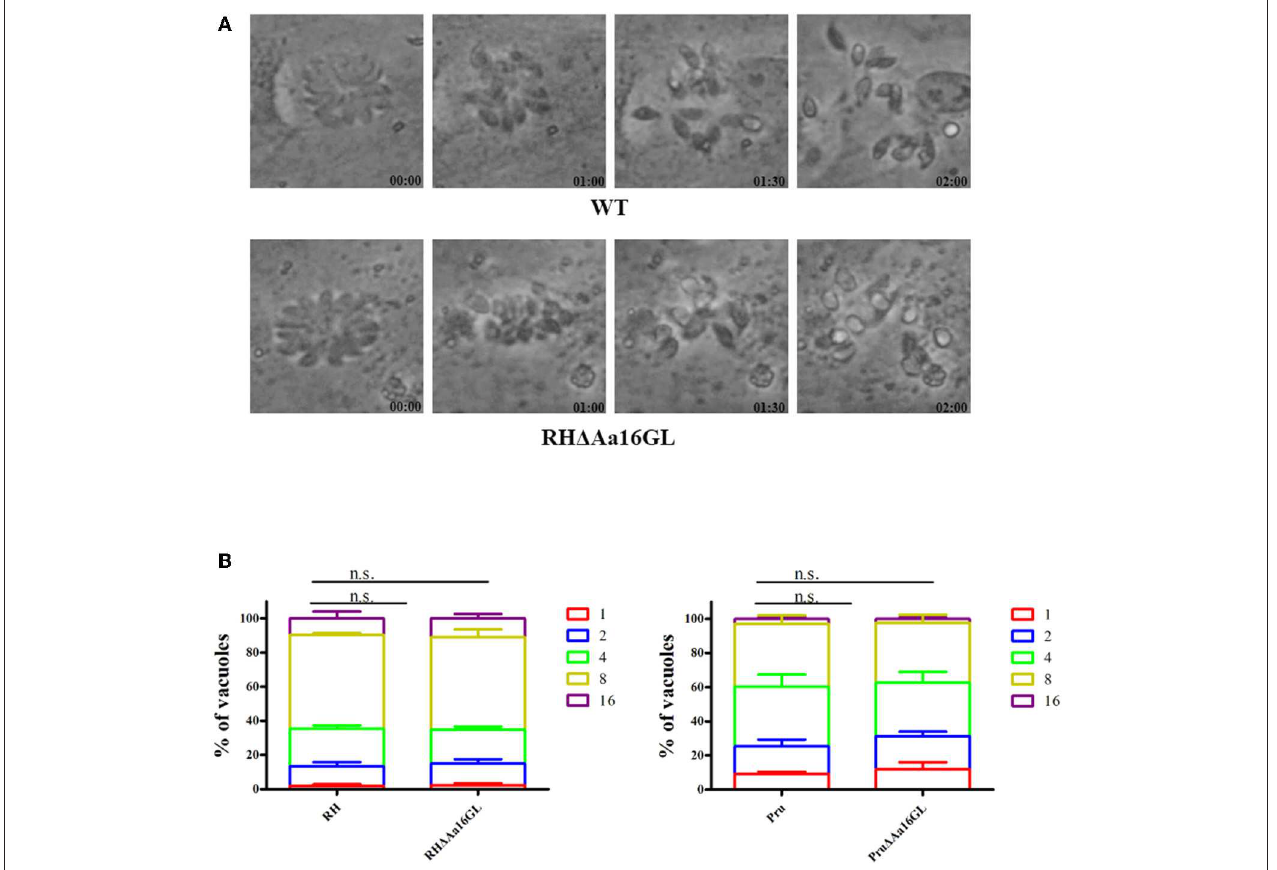
FIGURE 4 | Egress and intracellular replication of amylo-alpha-1,6-glucosidase-deficient tachyzoites in vitro . (A) The parasite egress of the parental WT (RH strain) and Aa16GL mutant (RH strain). A similar egress pattern was observed between WT strain and Aa16GL mutant strain after addition of 3 µ M calcium ionophore A23187 into culture medium. (B) WT (RH strain, Pru strain) and corresponding Aa16GL mutant strains were allowed to infect HFF monolayers for 24h, and the numbers of vacuoles containing 1, 2, 4, 8, or 16 parasites were counted. At least 200 vacuoles were analyzed for each strain, each was performed in three independent experiments. n.s, not significant, Student’s t